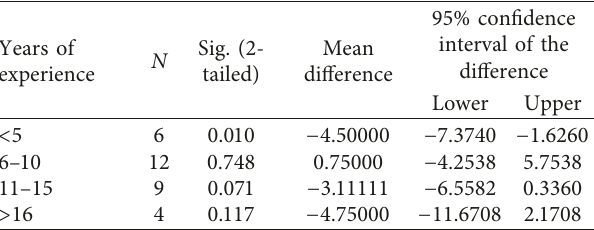
Table 6: Statistic and one-sample t -test for depersonalization with reference to years of